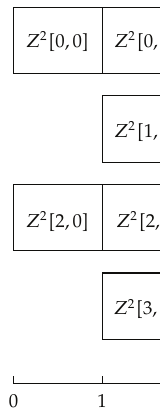
Figure 4: Valid schedule of length three for graph Z 2 .